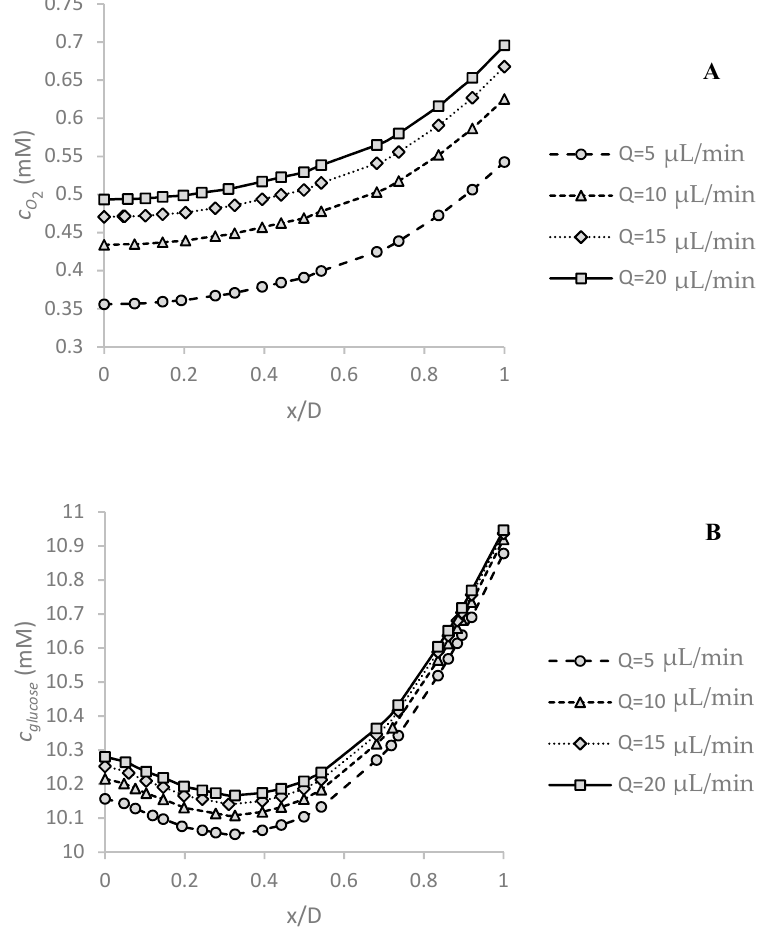
Figure 5. The effect of medium volume flow rate Q on ( A ) oxygen and ( B ) glucose concentration profiles in the center of spheroid along x -axis (defined based on the dimensionless x position: x / D ). The effect of changing the flow rate is more pronounced on the oxygen concentration compared to that on the glucose. When the medium flow rate increases by 300%, the maximum concentrations of oxygen and glucose increase by 38% and 1%, respectively. The simulations were carried out for D = 500 µ m, c 0, O 2 = 0.2 mM and (cid:1855) (cid:2868),(cid:3034)(cid:3039)(cid:3048)(cid:3030)(cid:3042)(cid:3046)(cid:3032) = 11 mM .